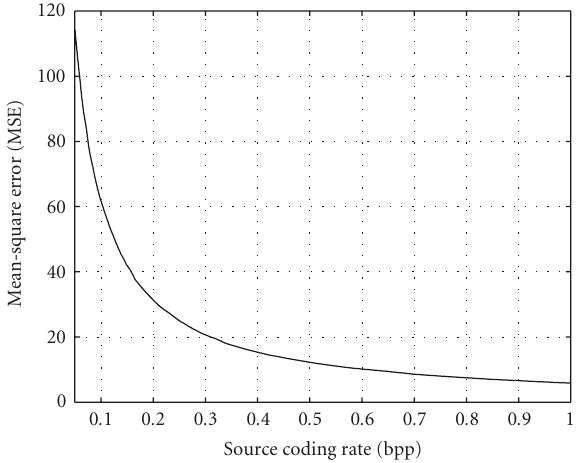
Figure 1: Operational distortion-rate function D ( r s ) of the SPIHT 512 Lena coder for the 512 (cid:0)